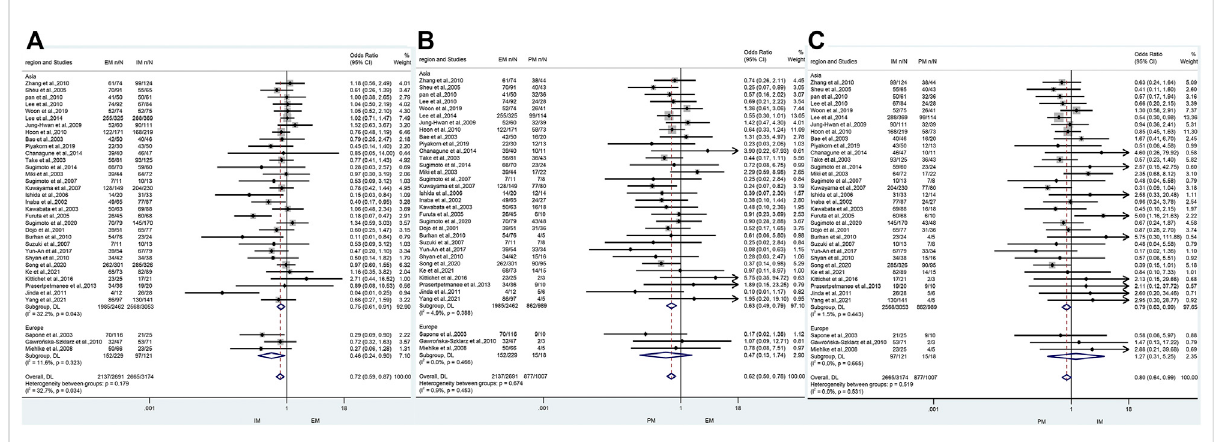
FIGURE 6 (A) Forest plotofEMvs.IMinrelationtothe H.pylori curerateintheCYP2C19 genotype indifferentregions( p =0.034). (B) Forest plotofEMvs. PMinrelationtothe H.pylori curerateintheCYP2C19genotypeindifferentregions( p =0.453). (C) ForestplotofIMvs.PMinrelationtothe H.pylori cure rate in the CYP2C19 genotype in different regions ( p = 0.531). p = 0.05, signi fi cant heterogeneity, or statistically signi fi cant, when appropriate. p < 0.05,random-effectsmodel; p > 0.05,random-effectsmodel.Symbol: ,singlestudiesincludedinthemeta-analysis; ,samplesizeof single studies; , con fi dence interval (CI); , overall pool estimated; , tendency; , overall pool OR.